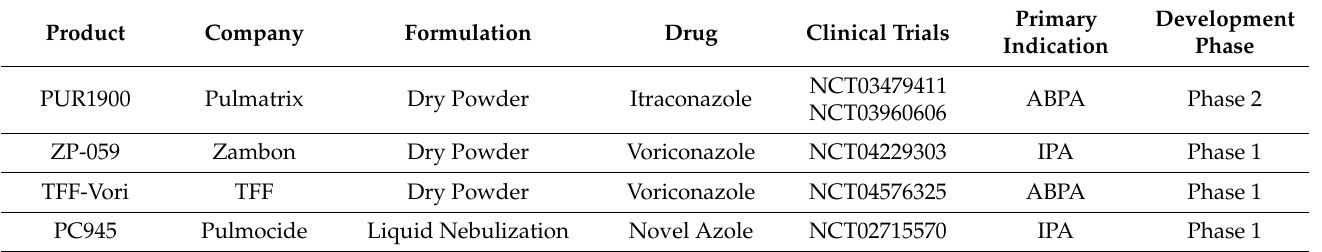
Table 2. Novel drugs in development as treatments of